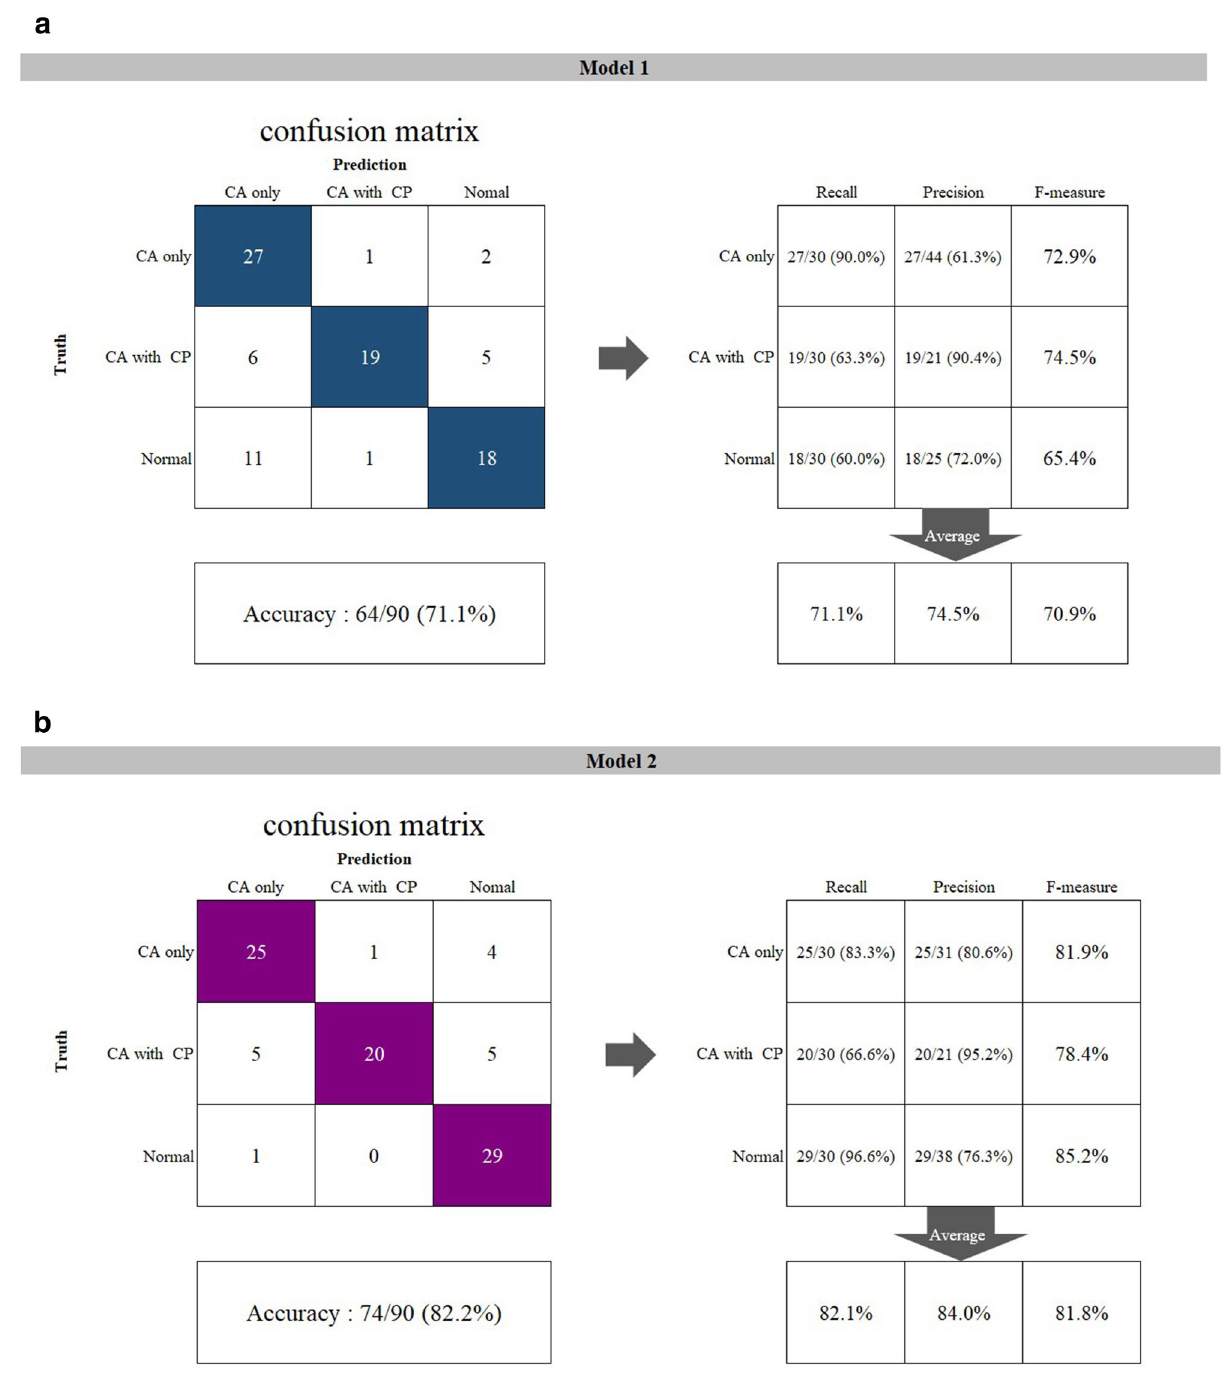
Figure 2. The confusion matrices of (a) model 1, (b) model 2, (c) human observer 1, and (d) human observer 2 and their calculated